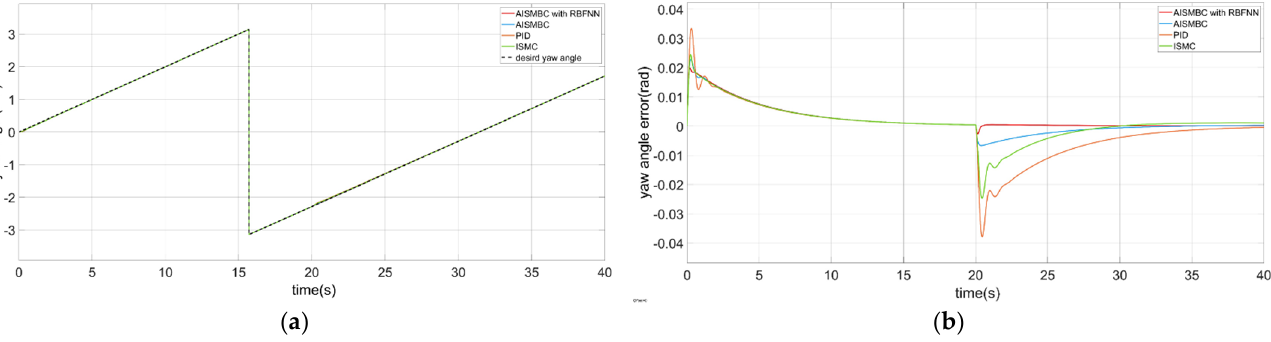
Figure 14. The yaw angle control. ( a ) The control results of yaw control with the three control methods. ( b ) The results of yaw angle tracking errors.